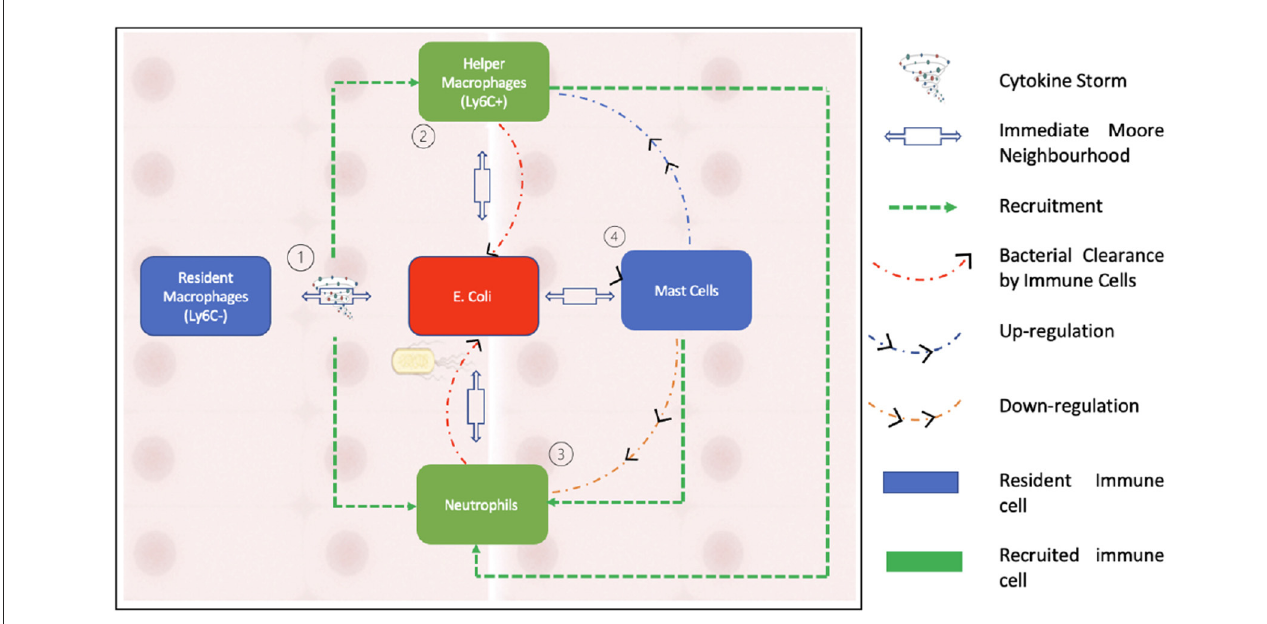
FIGURE2 This figure illustrates the interactions between the agents that form our model. As can be seen in the schematic, neutrophils are recruited by activated macrophages while being down regulated by mast cells. Bacterial clearance occurs through helper macrophages and